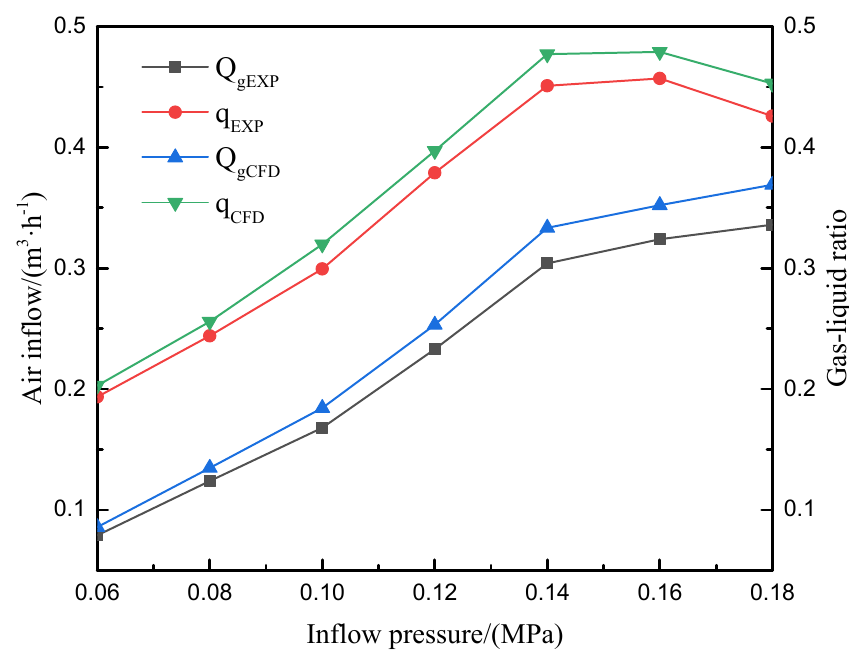
Figure 4. Comparison of numerical model and experiment.